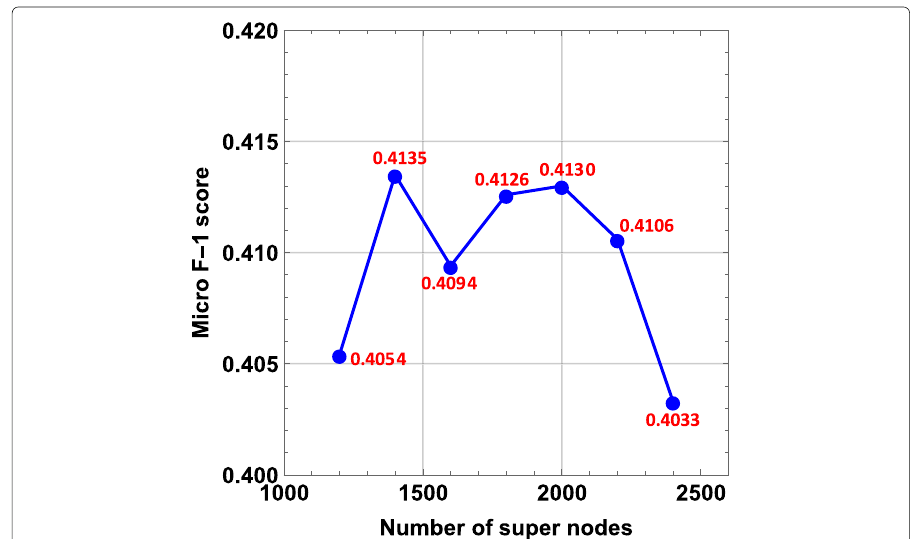
Fig. 7 SURREAL’s Performance with respect to various numbers of supernodes of supergraph summary method for Wekipedia dataset. No significant growth or drop in performance while increasing the number of supernodes